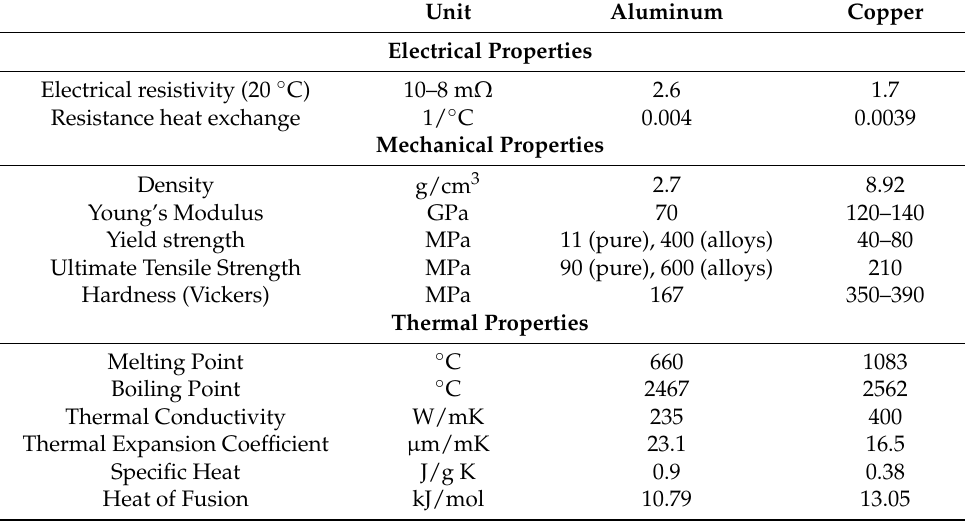
Table 1. Material properties of aluminum and